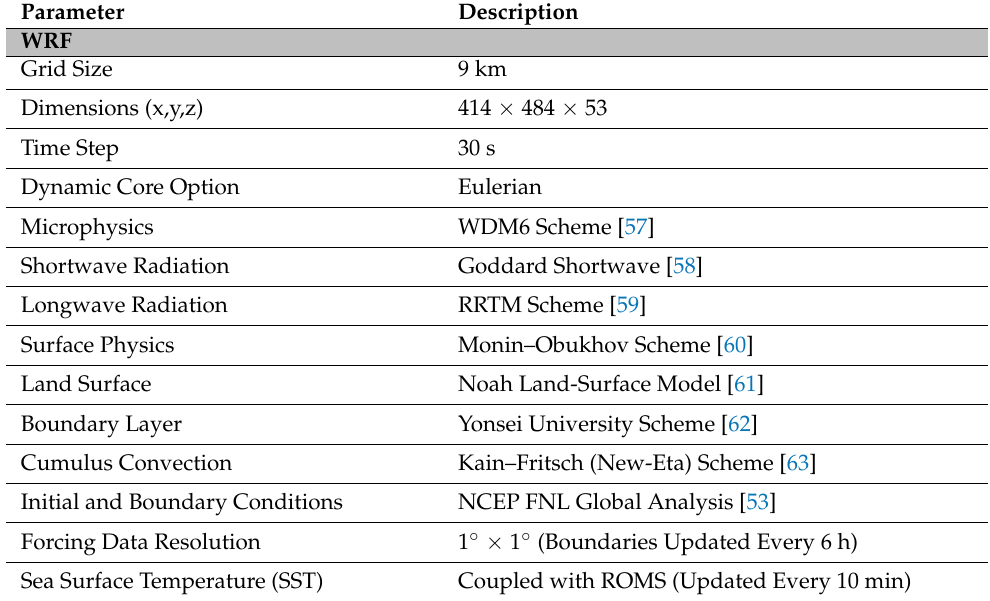
Table 2. Detailed description of the model